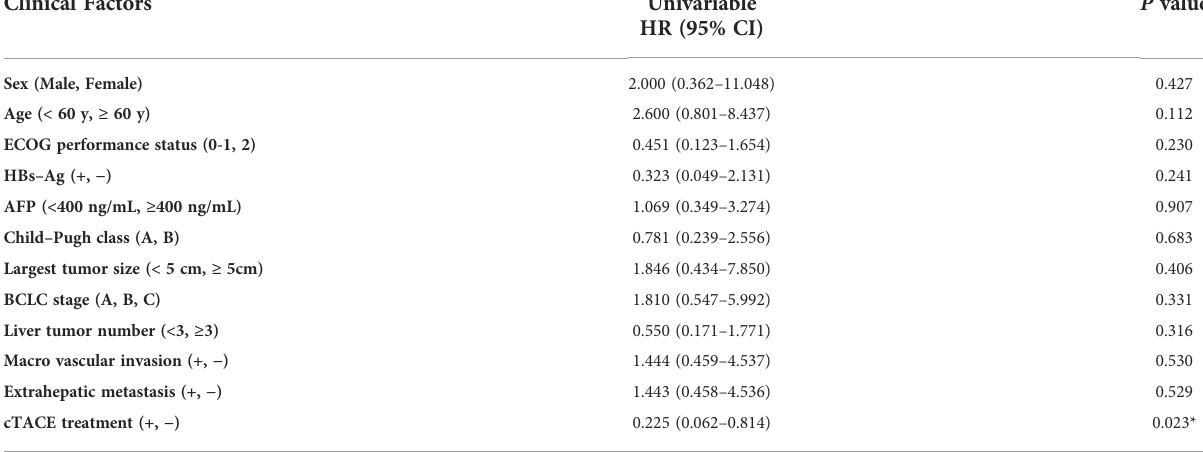
TABLE 3 Logistic analysis of clinical factors for ORR (with two cycles of ICI) in 54 HCC patients. Clinical